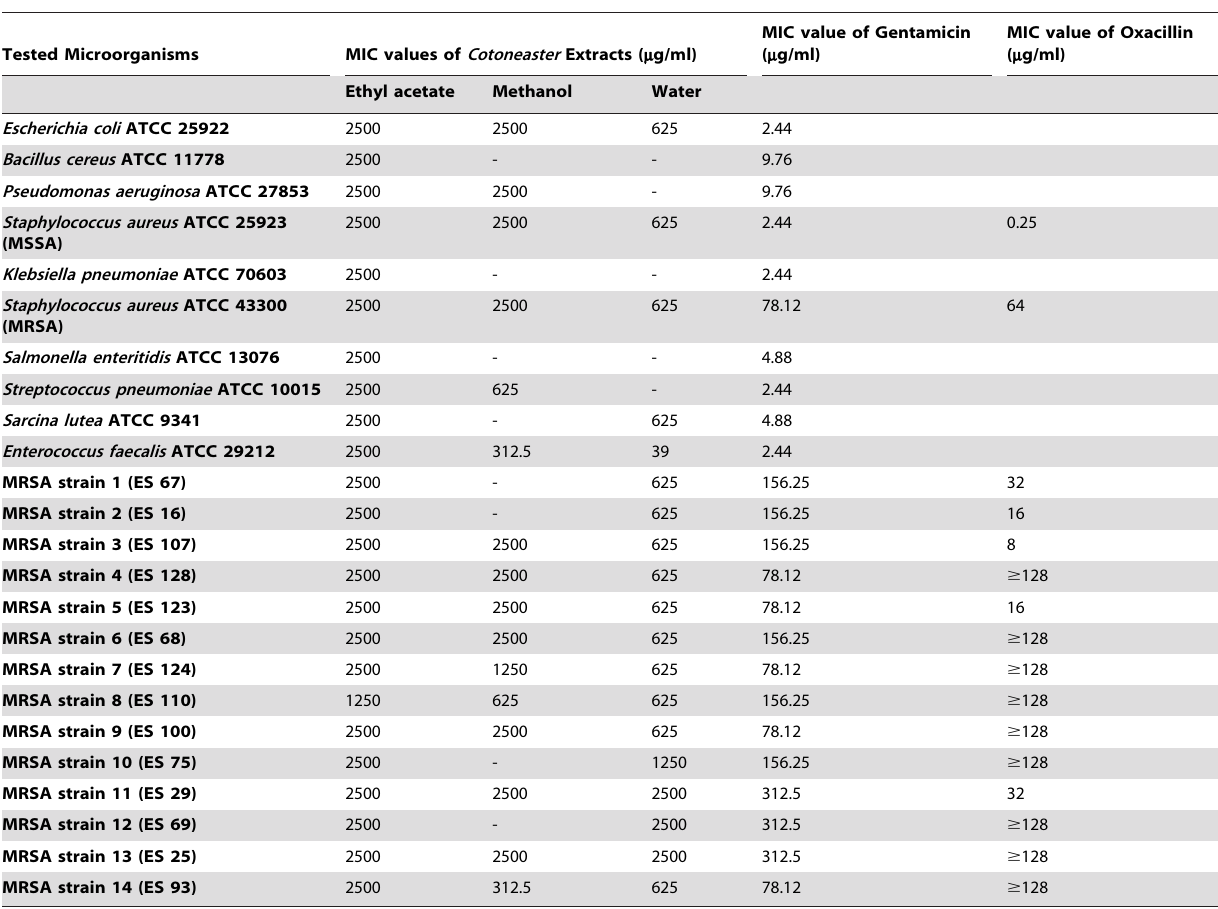
Table 4. MIC values of Cotoneaster extracts against standard bacteria and MRSA strains isolated from clinical samples.